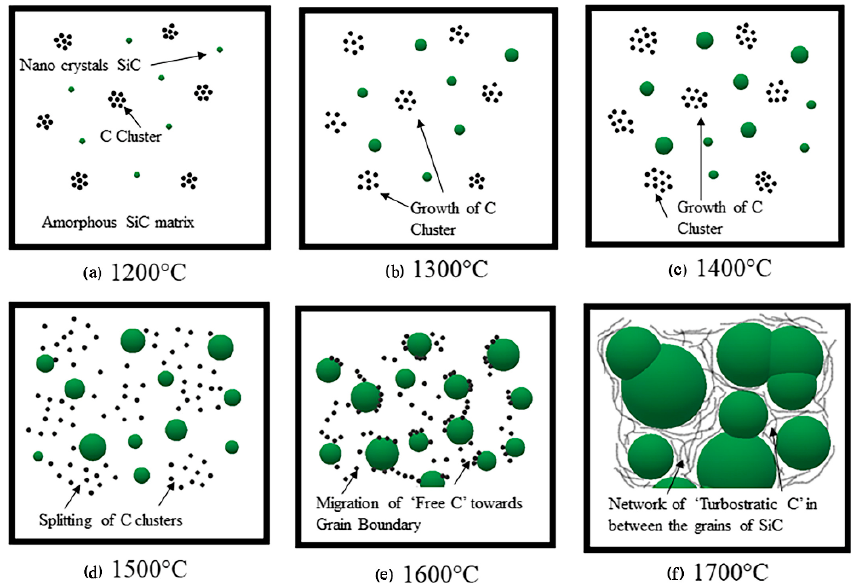
Figure 8. The effect of temperature on the evolution of microstructure. ( a ) 1200 °C: Carbon clusters in amorphous PDCs-SiC, ( b ) and ( c ) 1300 °C–1400 °C: growth of carbon clusters and crystallization of small amount of SiC, ( d ) 1500 °C: splitting of carbon clusters into nanocrystallized carbon, ( e ) 1600 °C: the migration of carbon structure toward the grain boundary of silicon carbide, ( f ) 1700 °C: excessive grain growth of SiC and formation of grain boundaries; the carbon segregated along the grain boundary forming a network of turbostratic carbon along the grain boundary of SiC [6]. Reproduced with permission from Xu C., J. Am. Ceram. Soc.; published by Wiley, 2019.